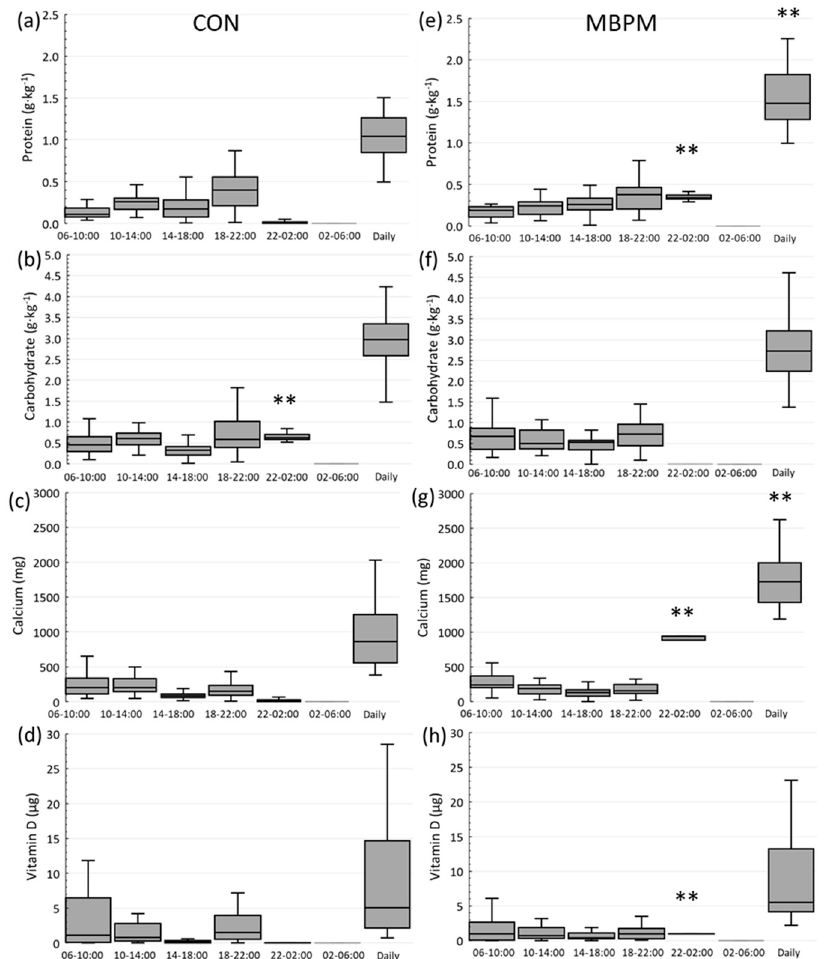
Figure 2. Four-hour epoch distribution of habitual nutrient intake and supplements for CON ( a – d ) and MBPM ( e – h ). ** denotes significant difference between CON and MBPM, p <